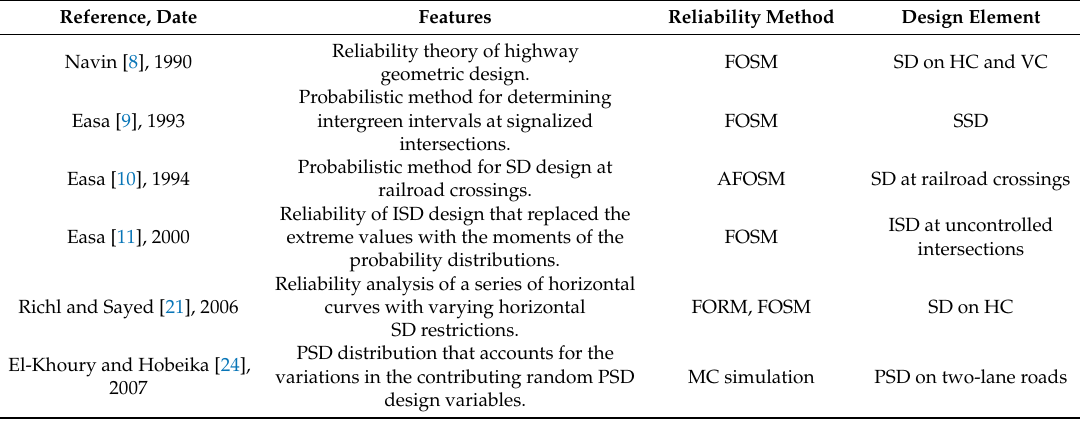
Table 1. Summary of existing reliability-based studies related to sight